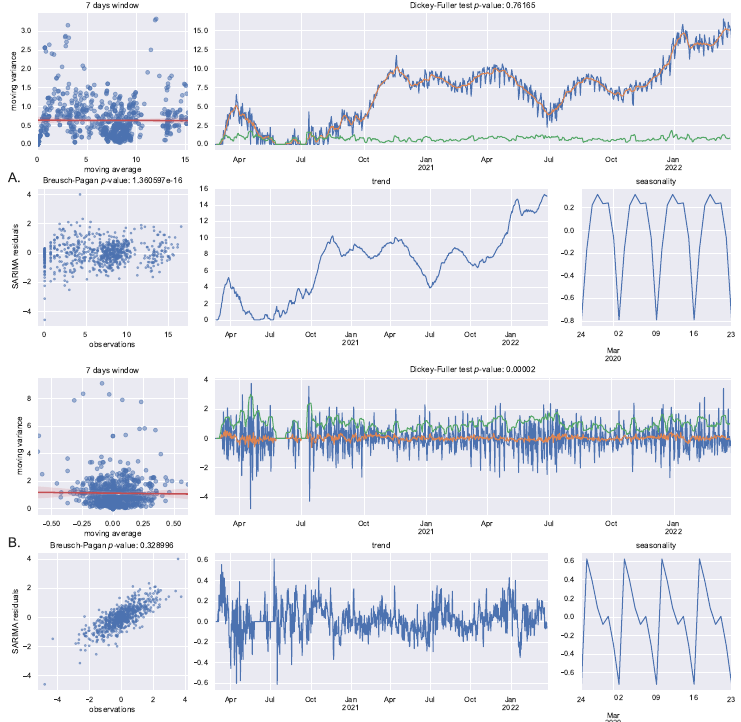
Figure 6. Data tests: ( A ) Box–Cox transformed data; ( B ) Box–Cox transformed and differentiated